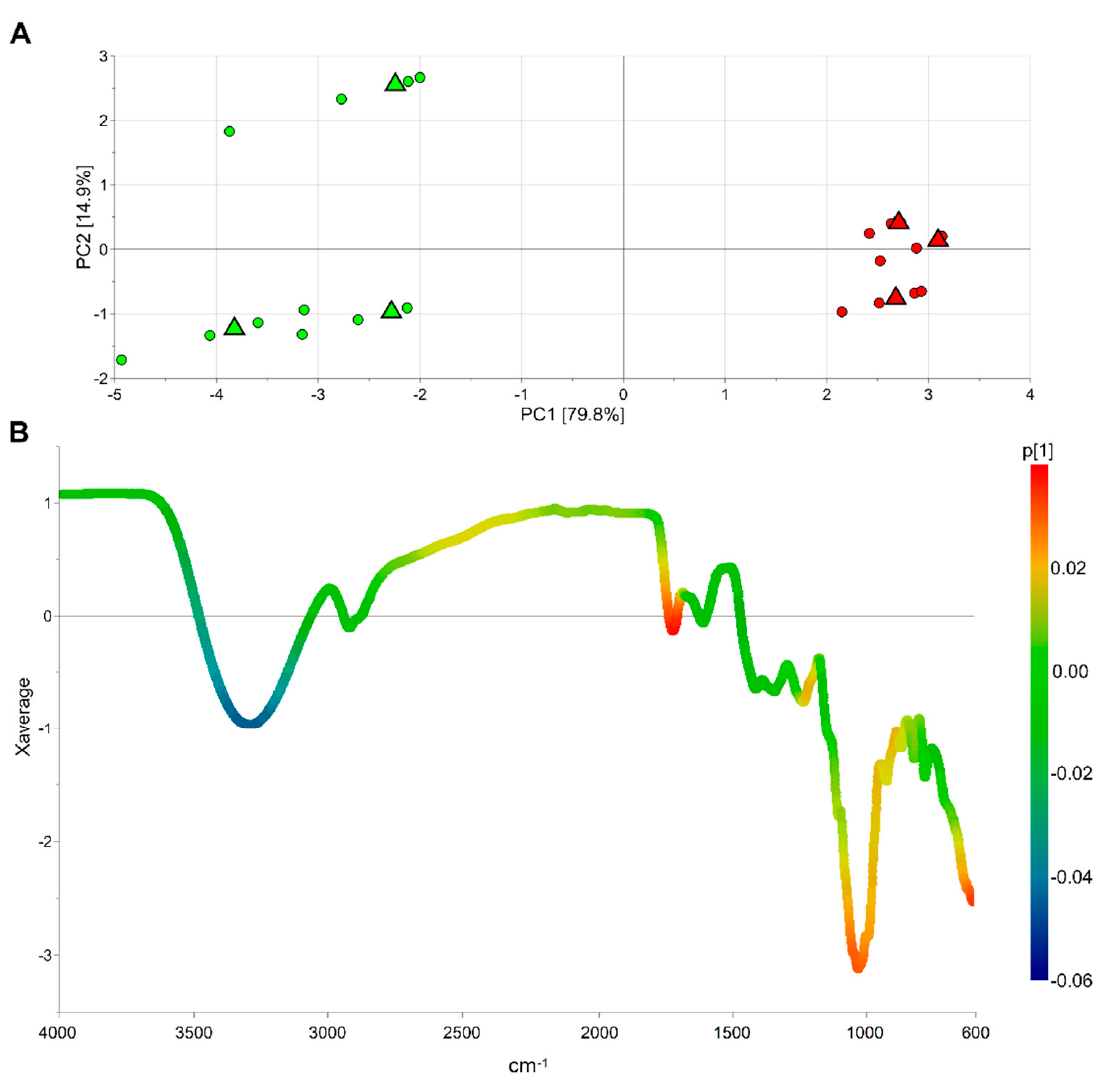
Figure 4. PCA model of the ATR-FTIR data: score scatter plot (panel ( A )) and average profile of the SNV data coloured according to the first loading vector (panel ( B )); in panel A, circles represent the technical replicates, triangles indicate the medians of the technical replicates of the same sample and green is used for observations belonging to the half-red group while red is used for those of the red group.